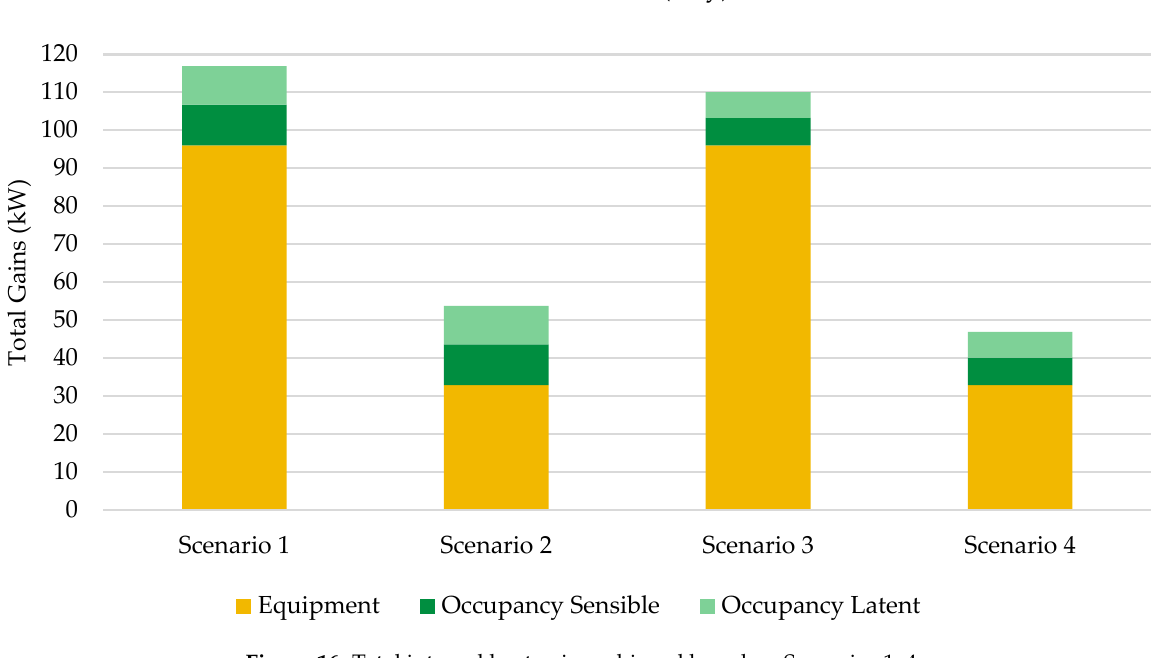
Figure 16. Total internal heat gains achieved based on Scenarios 1–4.